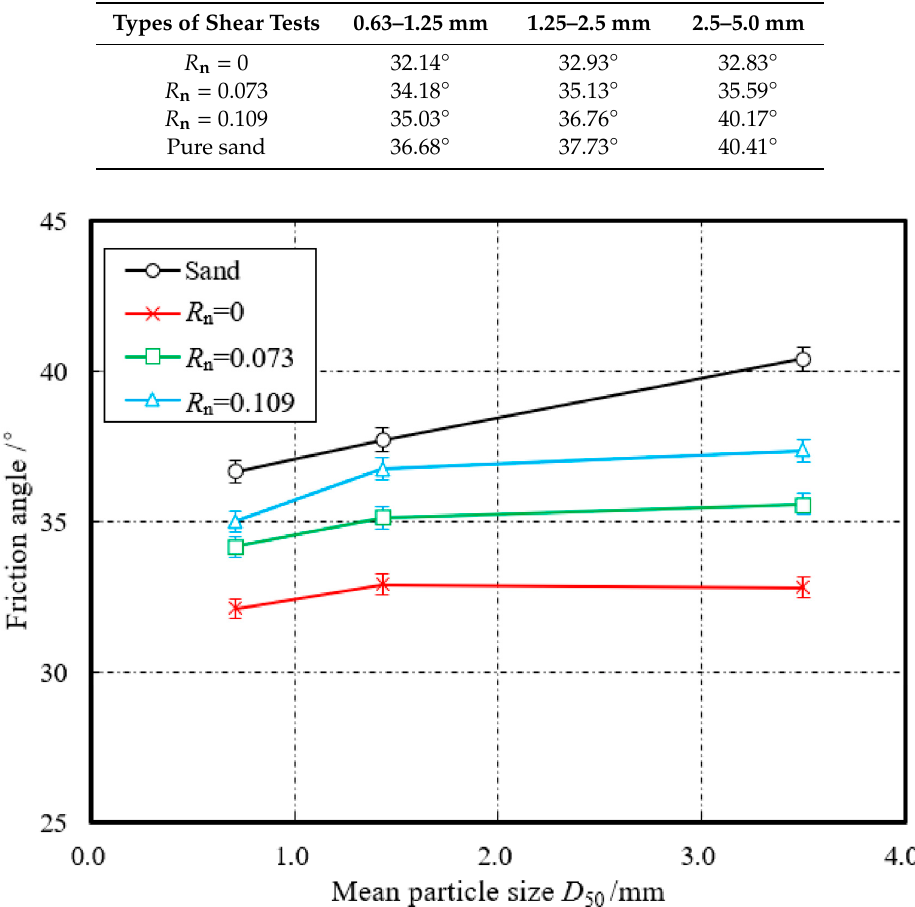
Figure 10. Relationships of mean particle size ( D 50 ) and friction angle ( ϕ ) obtained from the pure sand shear tests and the interface shear tests with di ff erent levels of relative roughness ( R n